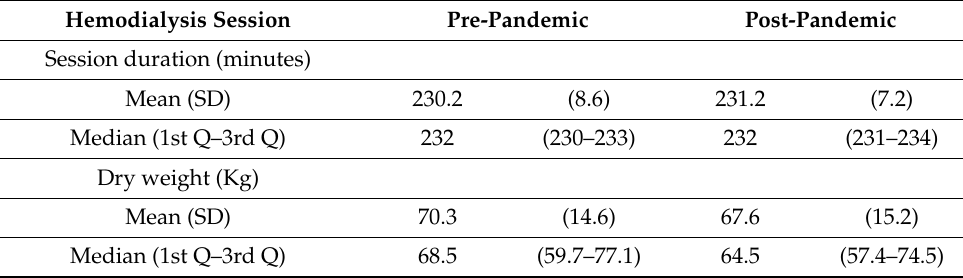
Table 2. Hemodialysis session details and biochemical characteristics across the